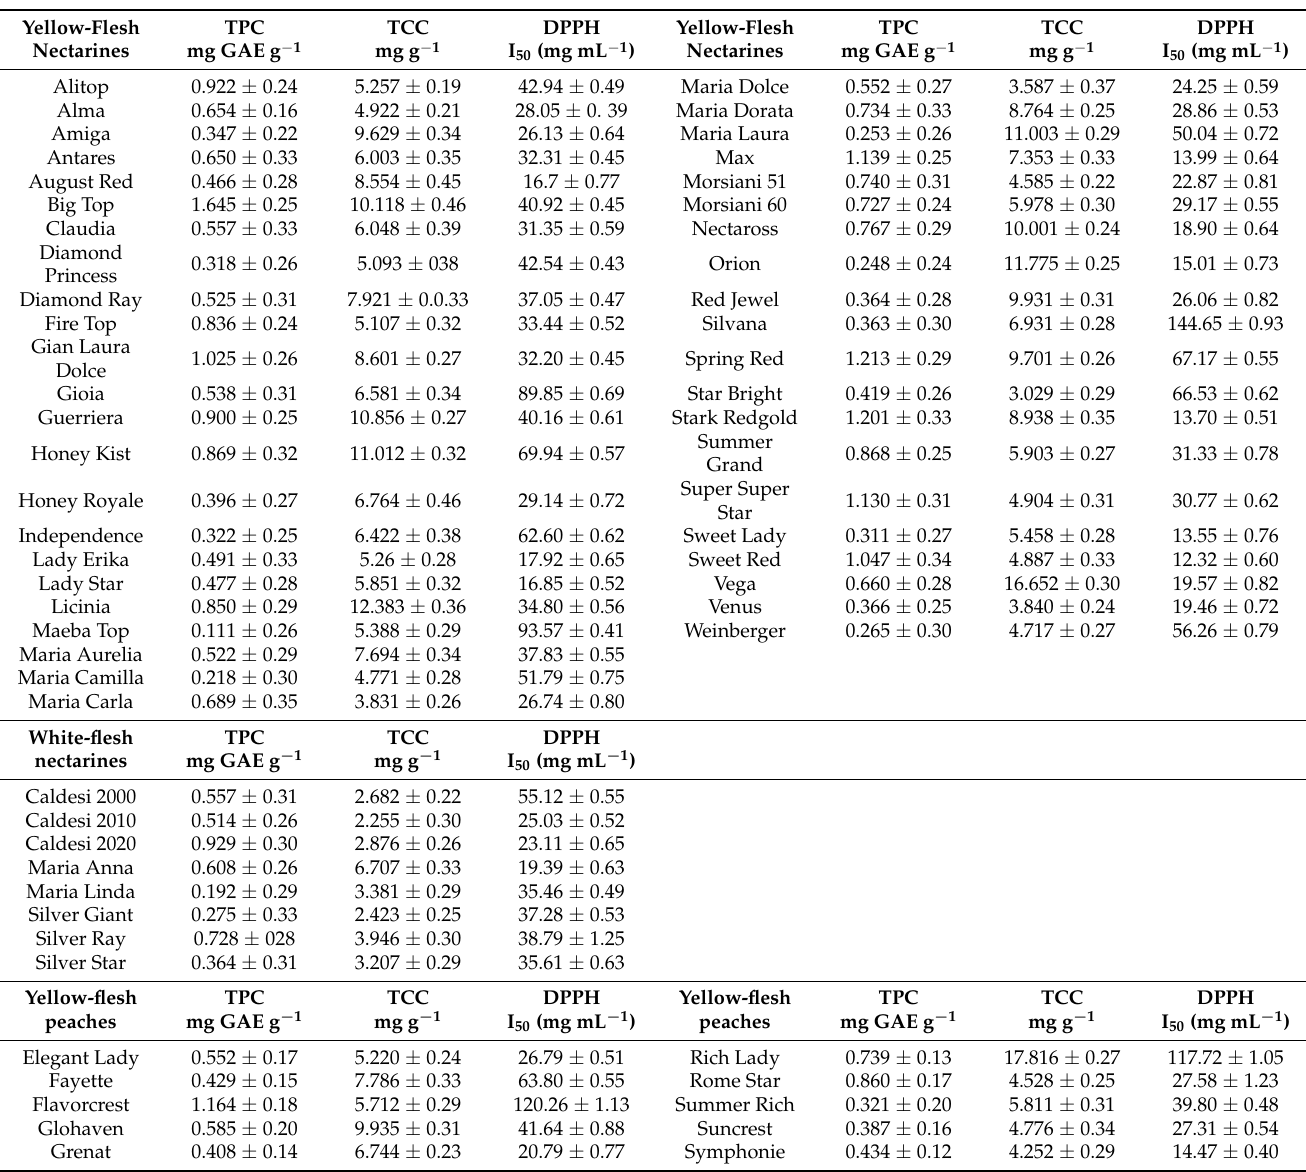
Table 6. Total Phenolic Contents (TPC), Total Carotenoid Contents (TCC) and Antioxidant Activity (DPPH) evaluated in yellow and white flesh of nectarine and peaches